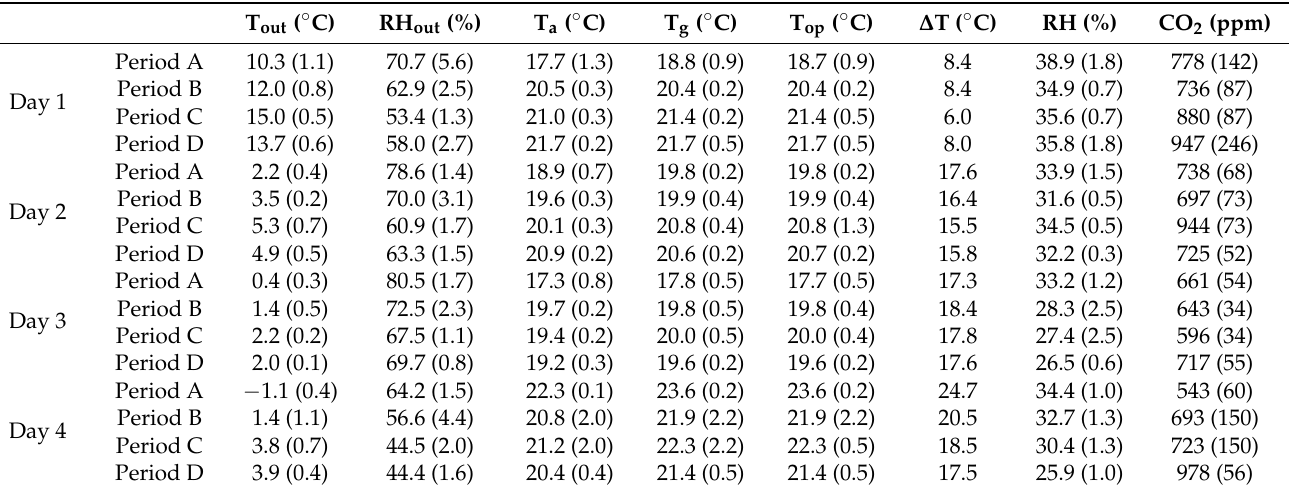
Table 4. Mean values of climatic parameters.